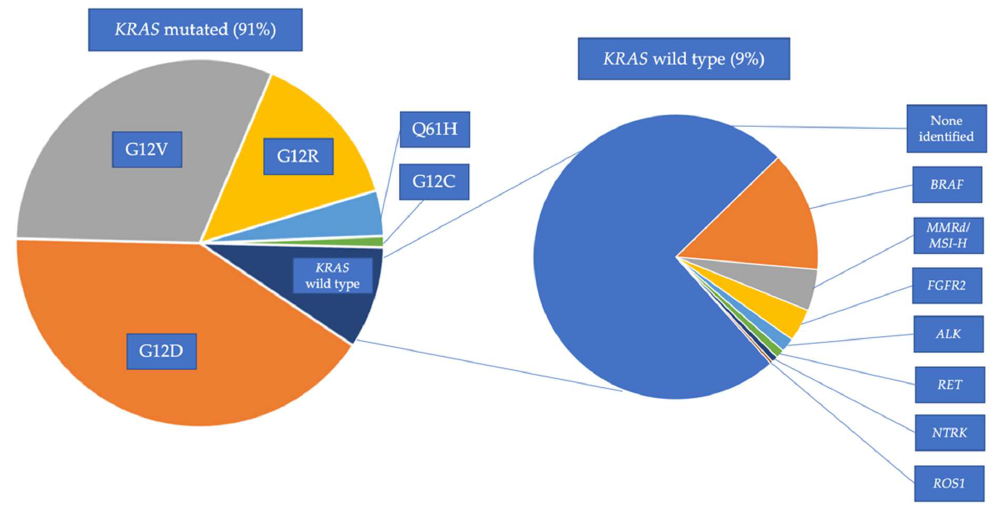
Figure 1. Oncogenic driver alterations in KRAS -mutated and KRAS wild-type PDAC. The proportion of KRAS mutations in PDAC include KRAS G12D (41%), G12V (31%), G12R (14%), Q61H (4%), G12C (1%), and KRAS wild-type (WT) (9%) [29,30]. Actionable alterations in KRAS WT patients in PDAC and pancreatic acinar cell carcinoma include: BRAF alterations (13.7%), MMRd/MSI-H (4.7%), FGFR2 fusions (3.5%), ALK fusions (1.6%), RET fusions (1%), NTRK fusions (0.7%), and ROS1 fusions (0.3%). Frequencies of genomic alterations in KRAS WT were derived from Philip et al. and Singhi et al. [29,30].